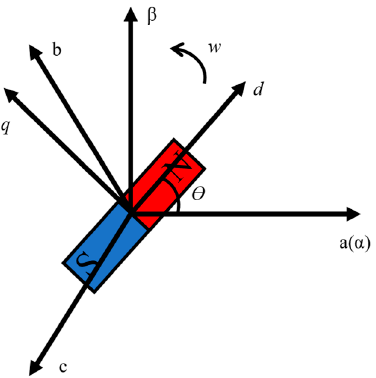
Figure 4. Relationship diagram between vectors in a spatial coordinate system.